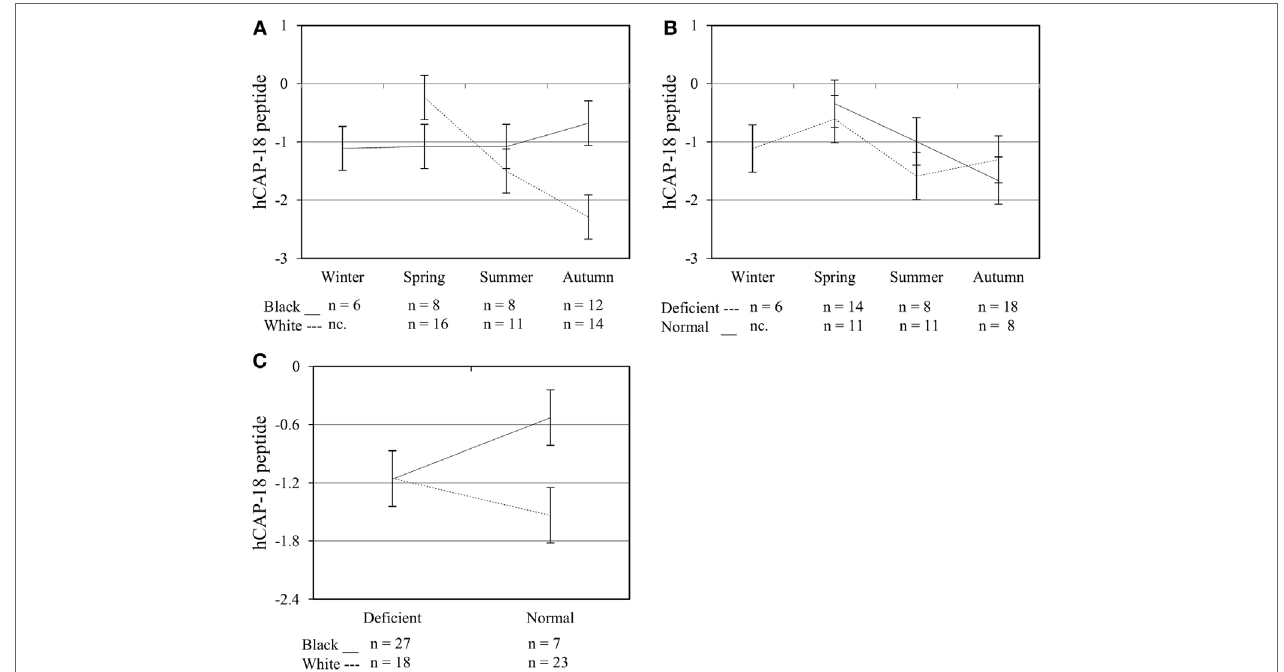
FigUre 6 | Interaction between season, race, and 25(OH)D 3 status influence intracellular hCAP-18 peptide level. The line graphs show the interaction effects for hCAP-18 peptide level, quantified by flow cytometry, in monocytes/macrophages from healthy Black ( n = 34) and White ( n = 41) South Africans. Season and race [ (a) , P < 0.001], season, and 25(OH)D 3 status [ (B) , P < 0.010], and race and 25(OH)D 3 status [ (c) , P < 0.001] interacted significantly to influence hCAP-18 levels. Error bars show the least significant difference at P < 0.050. nc. = not